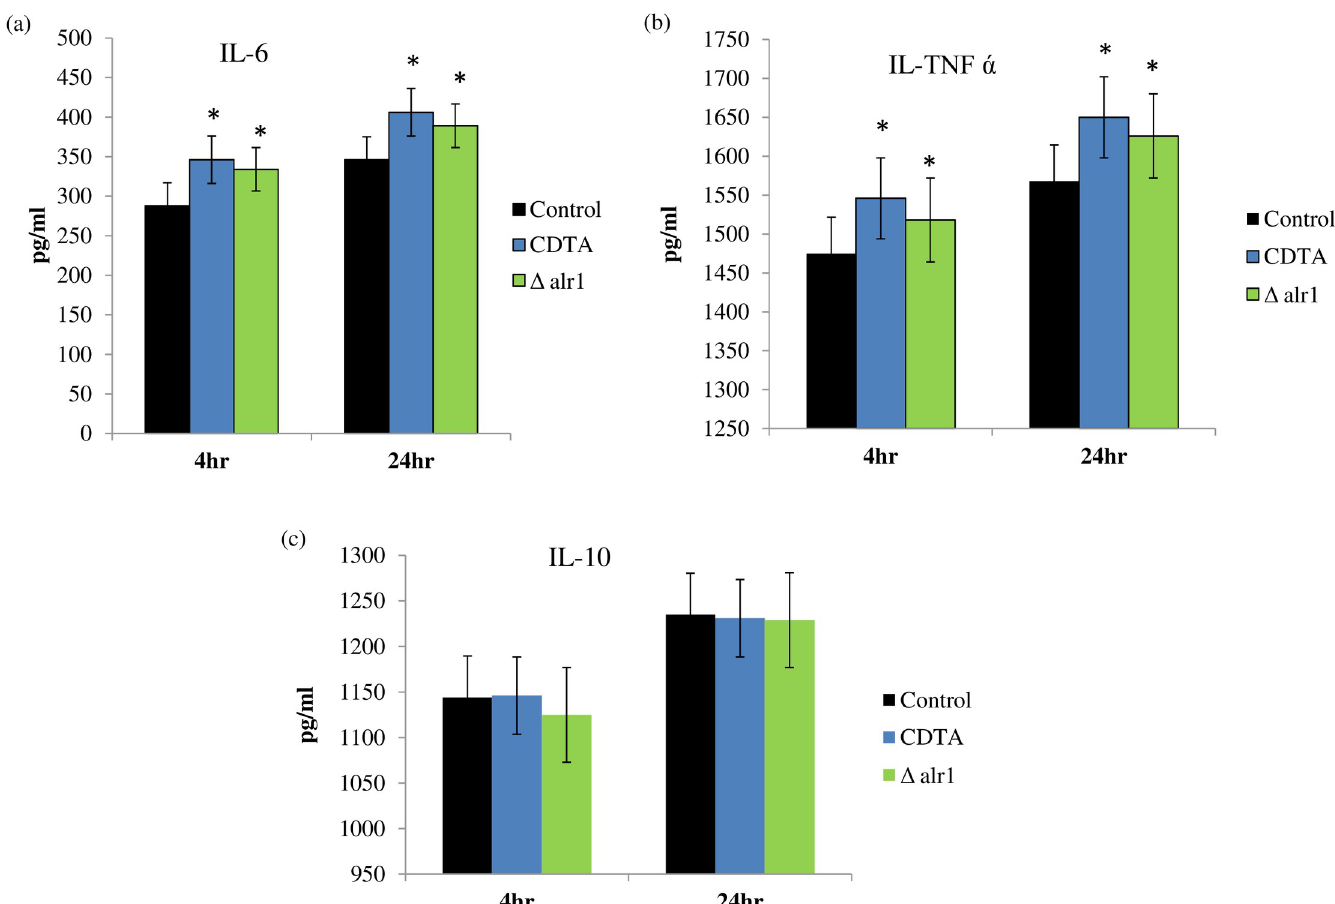
Fig 2. Cytokines stimulation under Mg deprivation. Bar graph represents cytokine levels measured in pg/ml on y-axis after 4- and 24- hours infection with control, CDTA treated and Δ alr1 C . albicans . Supernatants were collected after infection and analyzed with specific ELISA for cytokines ( a ) IL-6 ( b ) TNF α ( c ) IL-10. Cytokine titters were calculated by reference to standard curves generated by the four parameters logistic curve-fit method. The results represent the mean of three independent experiments, � depicts p value < 0.05.